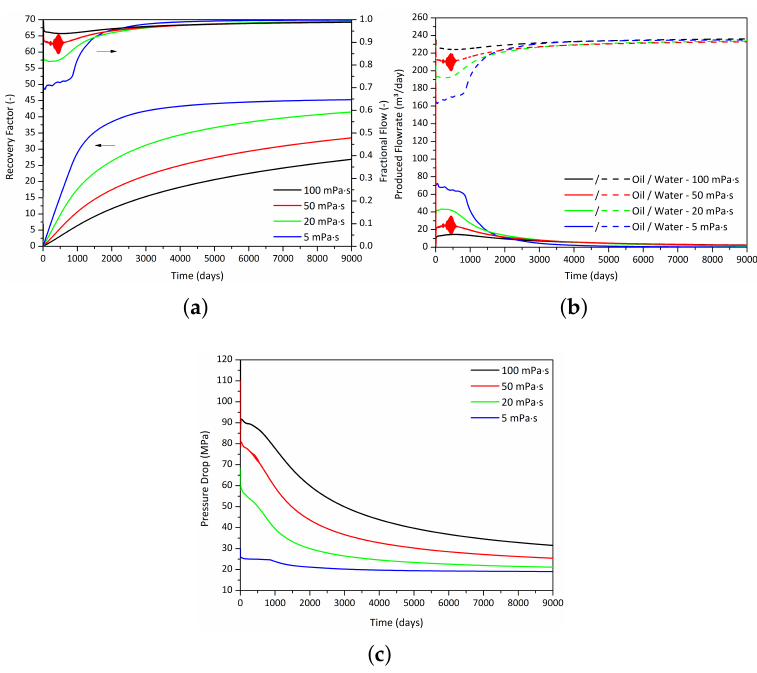
Figure 13. Cumulative oil production and fractional flow ( a ), oleous/aqueous produced flowrates ( b ); and pressure drop ( c ) for a non-iterative secondary recovery simulation in a heterogeneous medium for different oil